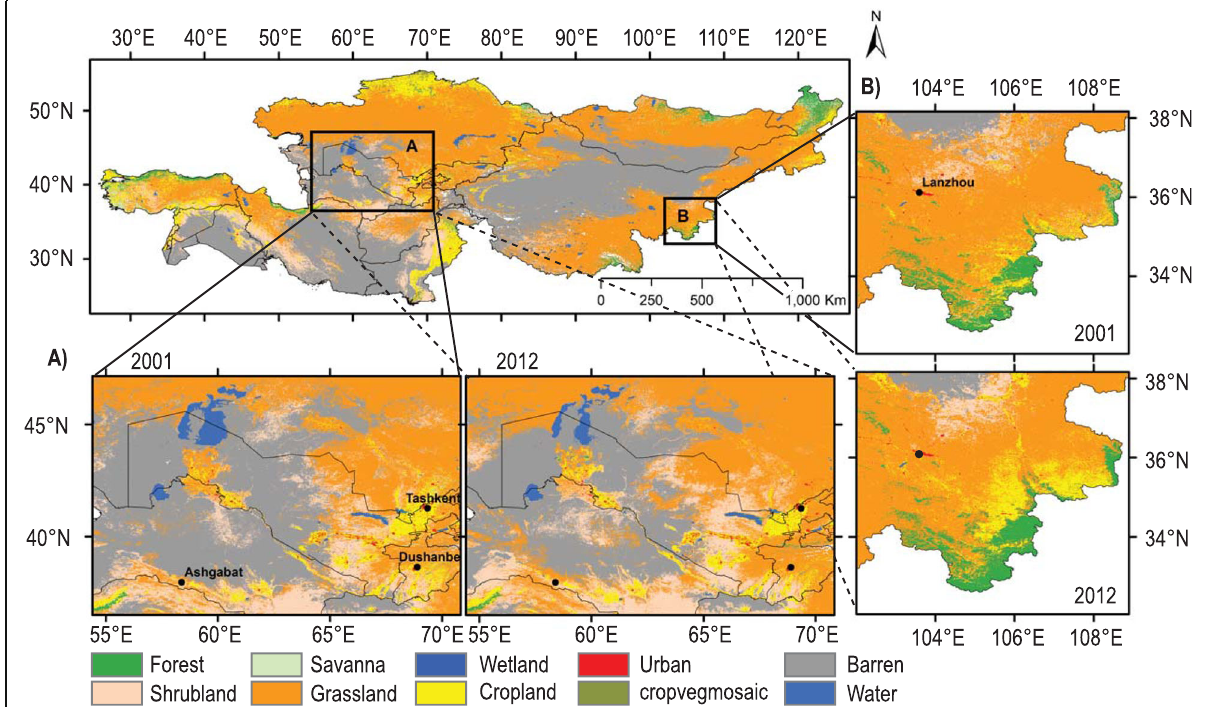
Fig. 15 Land use and land cover change in the Asian part of the DLB without steppe regions of Siberia from 2001 to 2012 (Qi et al. 2012, 2012 updated). Two zoomed windows show the land use and land cover changes between 2001 and 2012 in a the Central Asia around the Uzbekistan and b southern border of the Gobi Desert around Lanzhou,